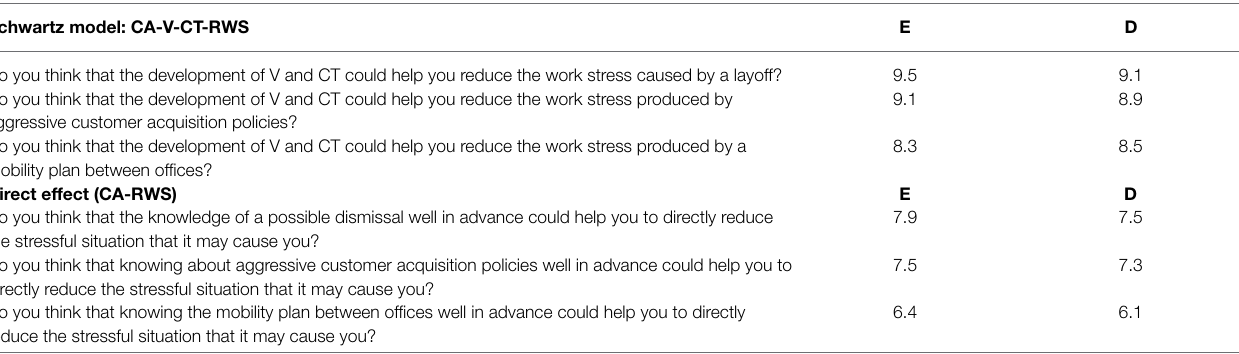
TABLE 13 | Direct and indirect mechanisms to reduce work stress ( n =